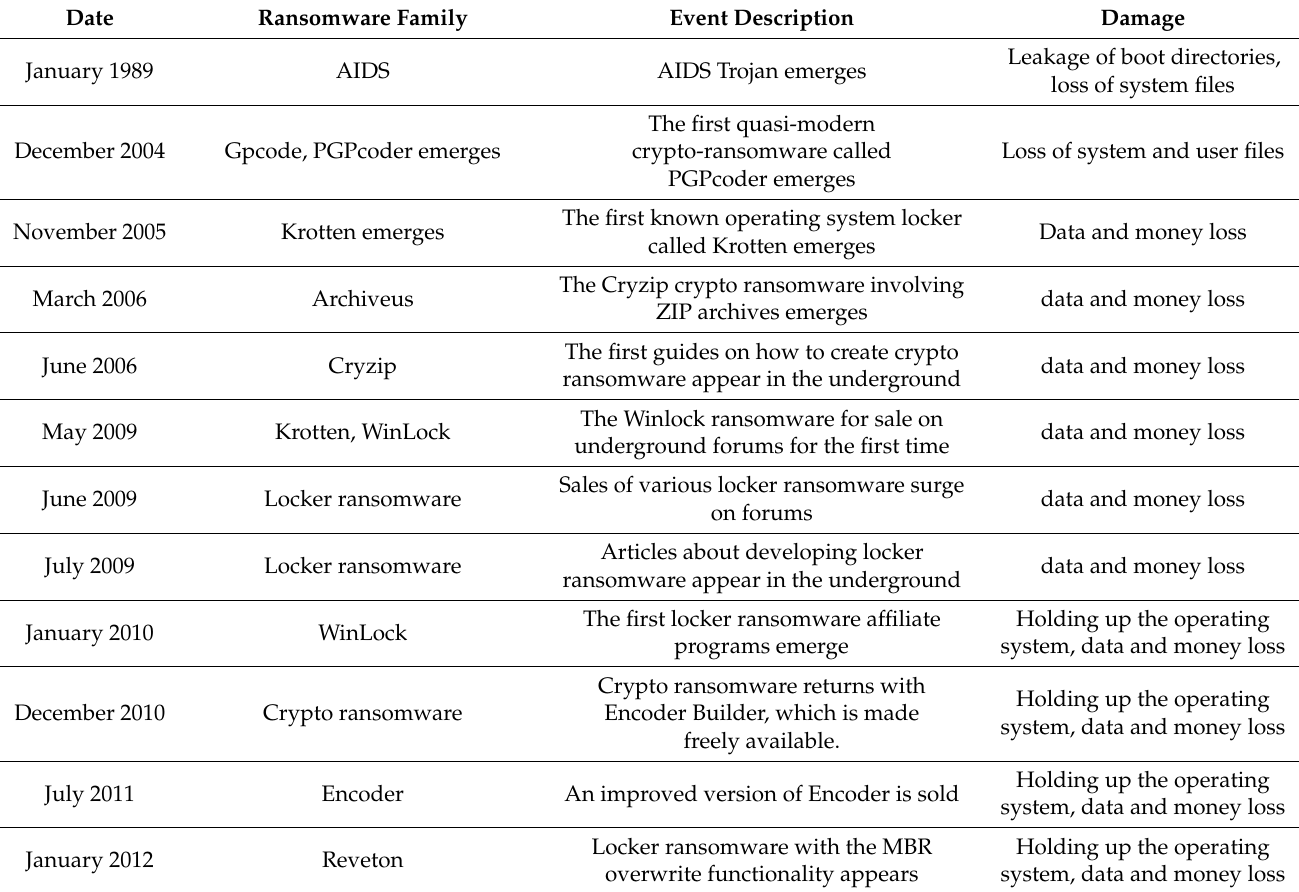
Figure 3. Ransomware evolution and trends timeline [19]. Table 4. Ransomware History Timeline.